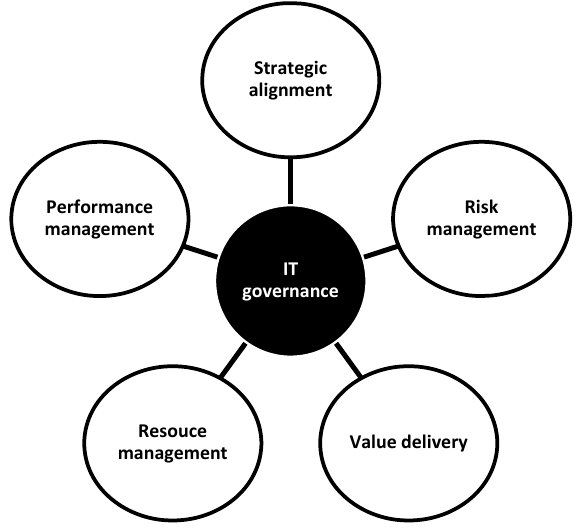
Figure 2: IT Governance focus areas according to King